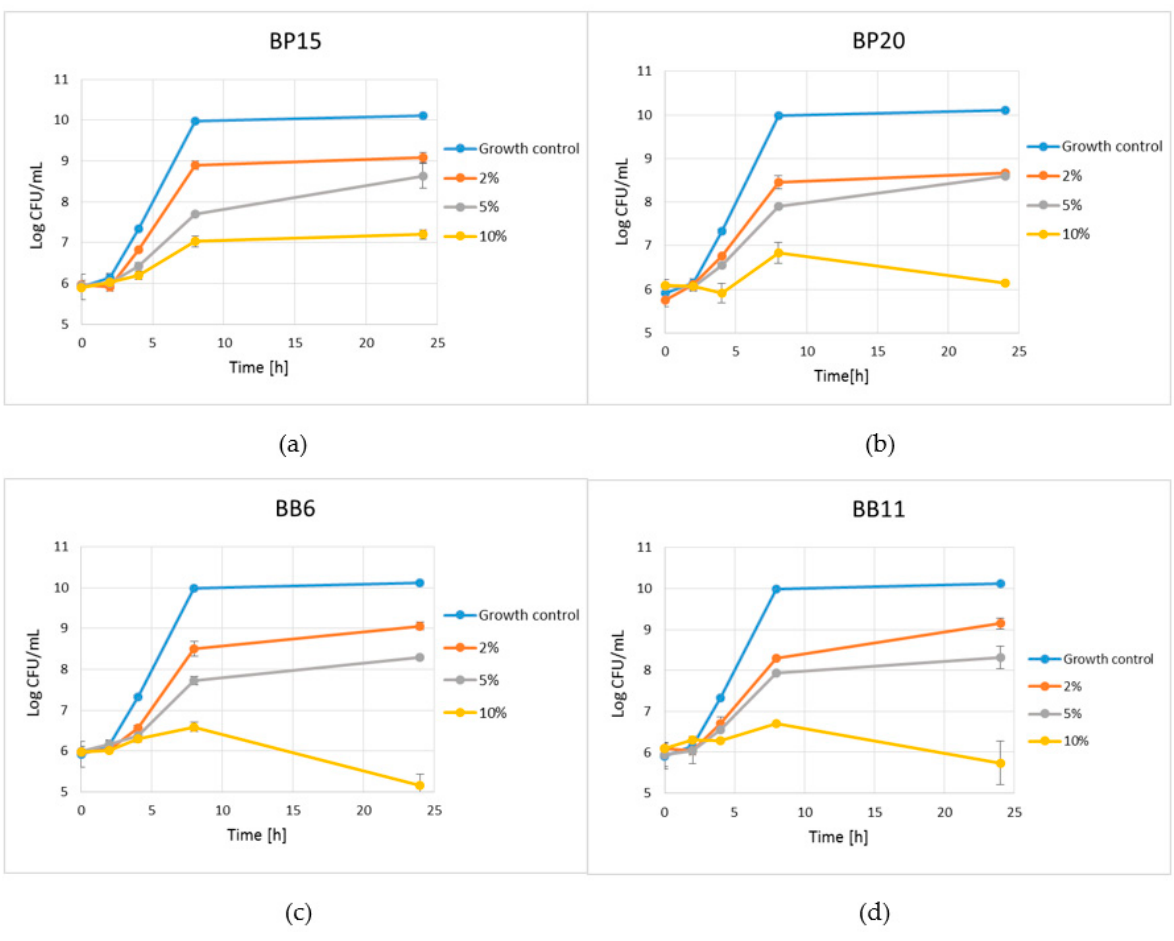
Figure 2. Kill-time assay for suspensions of selected products tested against S. aureus ATCC 29213 in final concentrations of 2%, 5% and 10% ( v / w ). The growth control did not contain any product; ( a ) BP15, ( b ) BP20, ( c ) BB6, ( d ) BB11. The results are presented as means ± SDs ( n = 3). Data without error bars indicate that the SDs are too small to be observed on the graph.